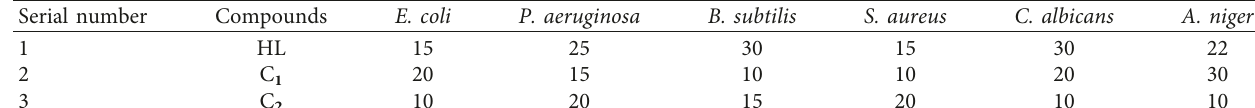
Table 6: Minimum inhibitory concentration (mg/mL) of compounds against bacteria and fungi.